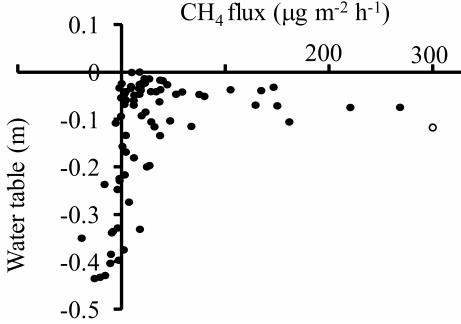
Fig. 3. The influence of water table height on CH 4 fluxes at Auchencorth Moss observed between 2007 and 2010 (data are monthly averages). The “off-scale” CH 4 flux in October 2007 was 604µgCH 4 m − 2 h − 1 and defined by an open circle.